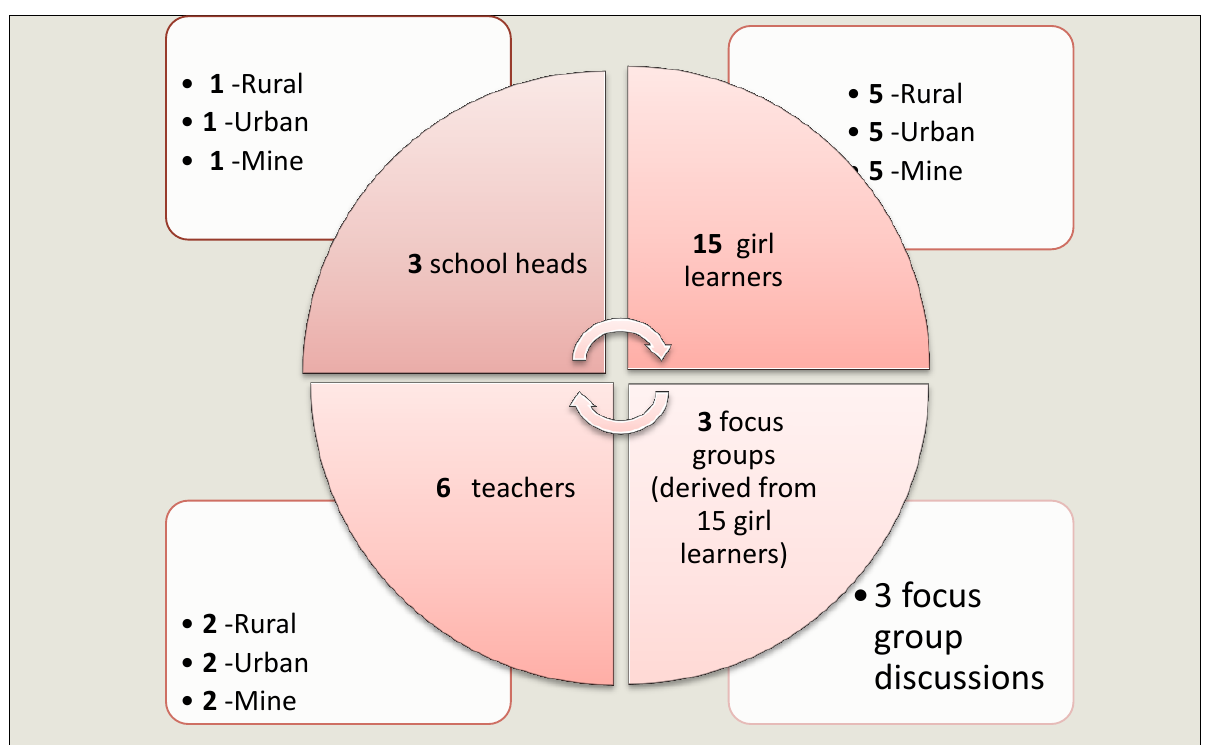
Figure 4.1: The sample of the